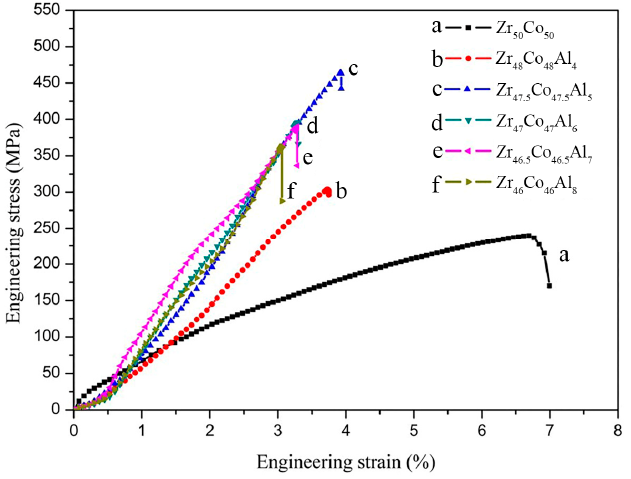
Figure 5. Engineering stress–strain curves of Zr 50 − x/2 Co 50 − x/2 Al x (x = 0, 4, 5, 6, 7, 8) alloys. Table 1. Mechanical properties of Zr 50 − x/2 Co 50 − x/2 Al x (x = 0, 4, 5, 6, 7, 8) alloys including the ultimate tensile strength (UTS) and ultimate failure strain